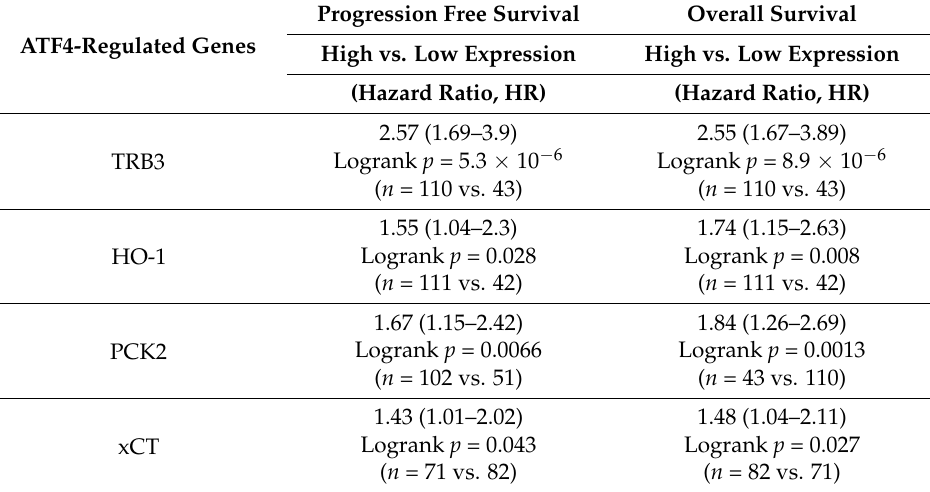
Table 1. The ATF4-regulated genes, tribbles-related protein 3 (TRB3), heme oxygenase 1 (HO-1), phosphoenolpyruvate carboxykinase (PCK2), and xCT, are associated with a poor prognosis in gastric cancer patients after adjuvant